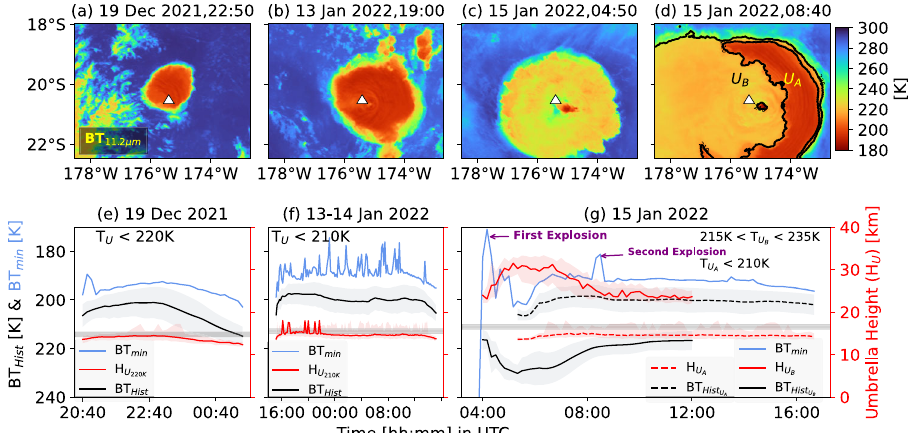
Fig. 1 Chronology of brightness temperature and altitude of umbrella clouds. a Himawari-8 observed brightness temperature at 11.2 microns (BT 11.2 μ m ) centered around HTHH (175.38°W, 20.57°S) submarine volcano on 19 December 2021 at 22:50 UTC. Panel ( b ), ( c ) and ( d ) are similar to panel ( a ) but for 13 January 2022 at 19:00 UTC, 15 January 2022 at 04:50 UTC, 15 January 2022 at 08:40 UTC, respectively. Two contour levels in panel ( d ) indicate U A and U B (separated umbrella clouds). The contour U A is outlined for BT 11.2 μ m (T U ) < 210 K, and contour U B is outlined for 215 K < BT 11.2 μ m (T U ) < 235 K. A B The colorbar represents the brightness temperature (BT 11.2 μ m ) measured in Kelvin [K]. The white triangle in a – d is centered around HTHH vent. e the black line (BT Hist [K]) indicates a histogram of BT 11.2 μ m associated with umbrella clouds at a contour level of 220 K during the HTHH eruptions on 19 – 20 December 2021 (initial eruption starting at 20:40 UTC on 19 December). The red line (H ) represents the umbrella height in km. The standard U 220K deviation associated with BT Hist [K] and H U are indicated using gray and light red shaded colors. The light blue line represents the minimum BT 11.2 μ m 220K (BT min ) covering the entire domain shown in the upper panel. The light gray horizontal bar around 16 km is the mean tropopause height during 19 – 20 December 2021. f Same as e but for 13 – 14 January 2022 (major eruption starting at 15:20 UTC on 13 January). g On 15 January 2022, BT Hist is shown for two distinct umbrella clouds: BT HistU (dashed red line) and BT HistU (solid red line). The umbrella heights H U and H U are estimated for corresponding A B A B BT HistU and BT HistU . Again, the light blue line represents the minimum BT 11.2 μ m (BT min ) covering the entire domain shown in upper panel d . Two A B explosions on 15 January in the interval of four hours are marked by purple color arrows. Processed datasets related to Fig. 1 can be found in the Supplementary Data